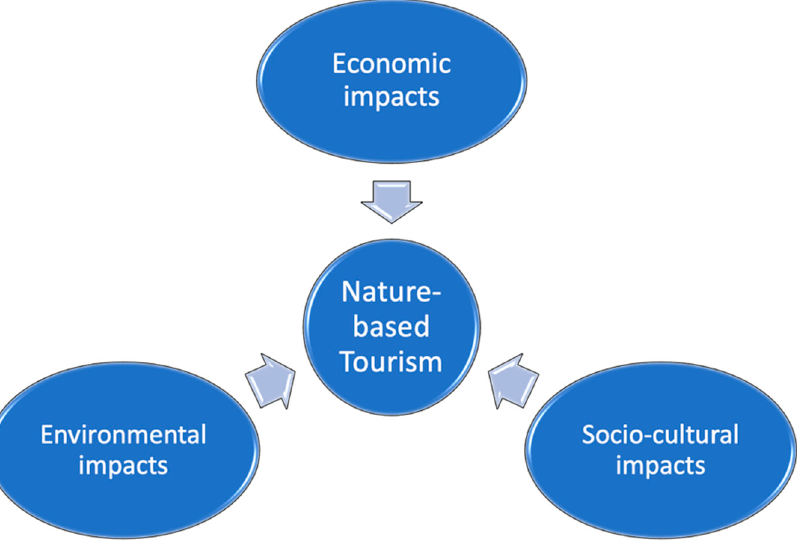
Figure 1. A breakdown of tourism’s impact.